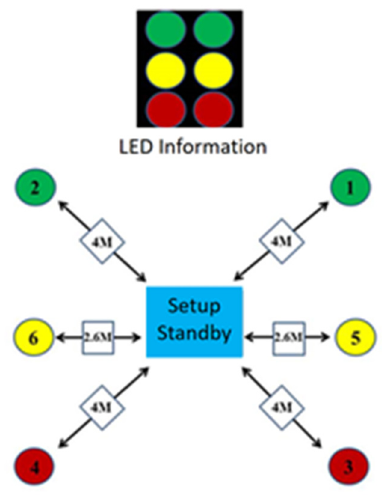
Figure 2. Six-point footwork test venue layout.